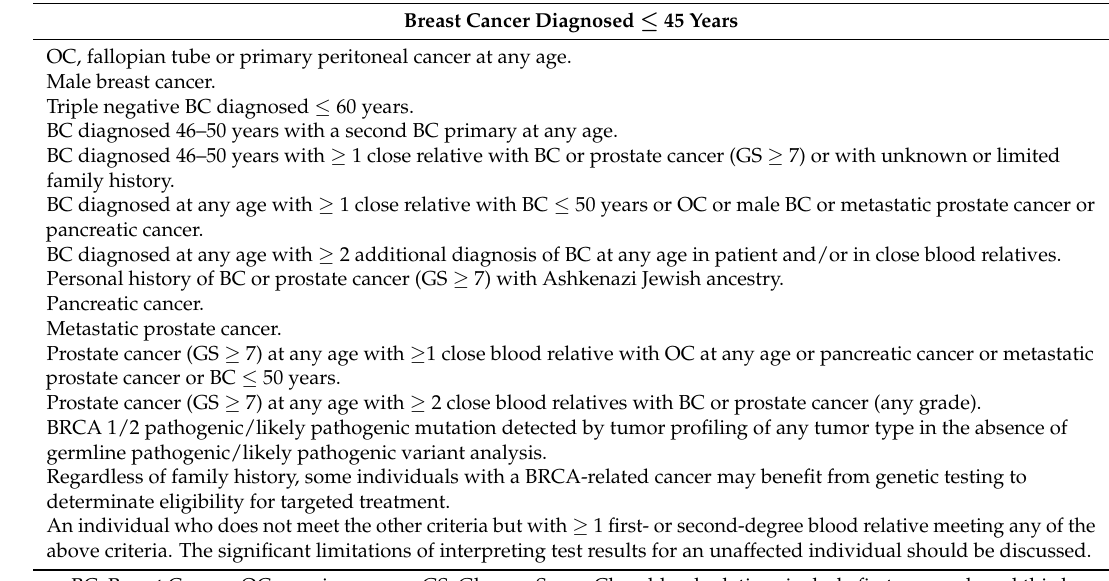
Table 1. The NCCN BRCA testing criteria (NCCN Guidelines Version 2.2019).